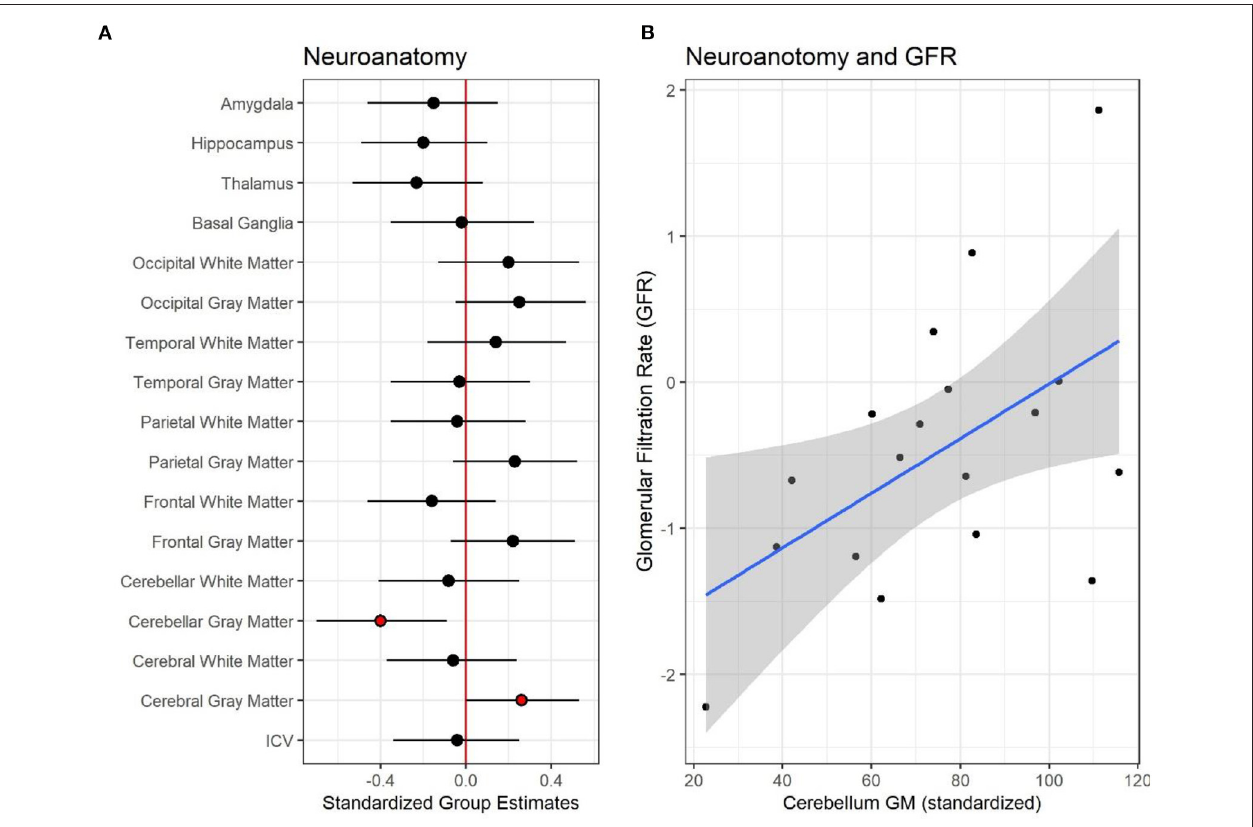
FIGURE 1 | Neuroanatomical differences between controls and patients with pediatric chronic kidney disease CKD. (A) Shows the standardized group estimates (x-axis) and 95% confidence limits of the estimates for each of the regions of interest (ROI) included in the analysis (y-axis). Estimates are adjusted for age, socioeconomic status (SES) and maternal education. The red (vertical) line marks 0, or no significant effect of group on ROI. Red circles mark significant group estimates. (B) Shows the relationship between estimated glomerular filtration rate, eGFR, (x-axis) and standardized cerebellum gray matter volume (y-axis) in the CKD group. Reproduced with permission from Solomon et al. (